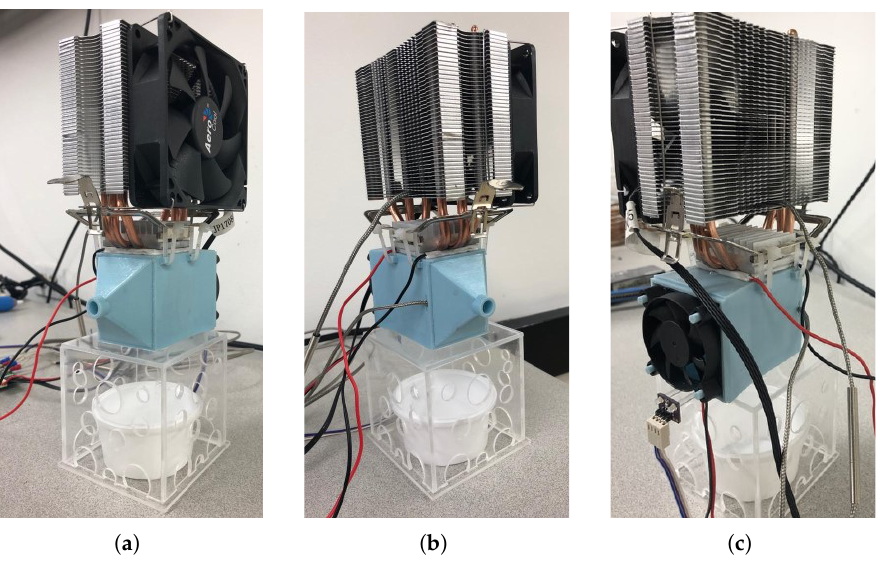
Figure 2. PAWG prototype [17]. ( a ) right side view; ( b ) left side view; ( c ) rear view.